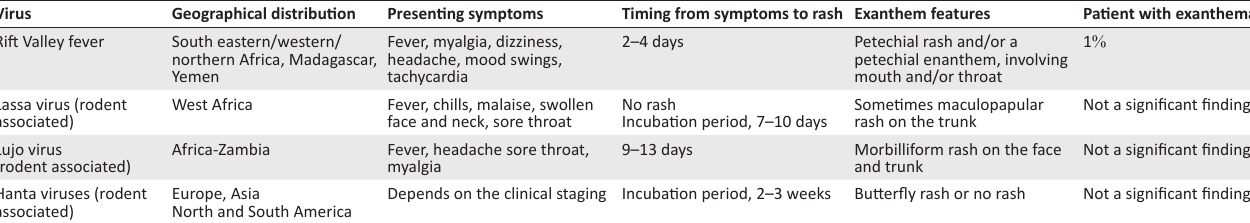
TABLE 2: Characteristics viral haemorrhagic fever in Africa. Virus Geographical distribution Presenting symptoms Timing from symptoms to rash Exanthem features Patient with exanthema Rift Valley